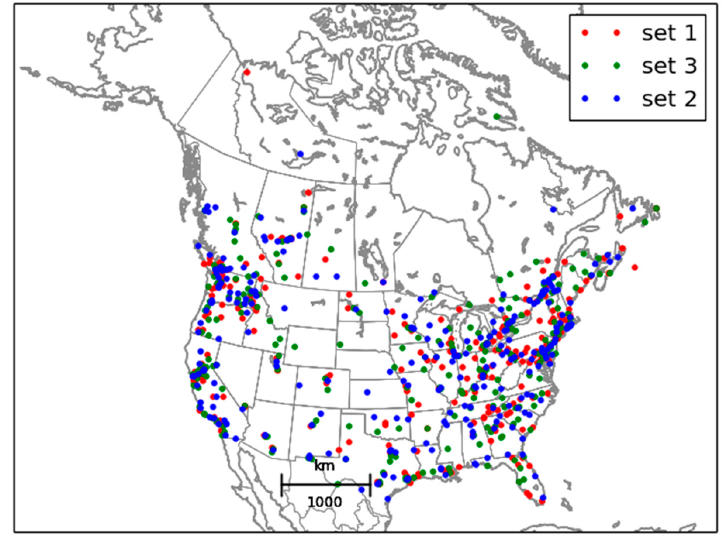
Figure 1. Spatial distribution of the three subsets of PM 2.5 observations used for cross-validation. The selection algorithm is based on regular picking of station by ID